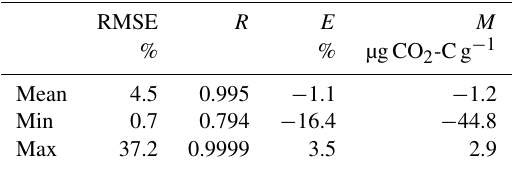
Table 7. Mean, minimum and maximum values for the statistical indicators of model goodness of fit between the measured and sim- ulated data ( n = 224).